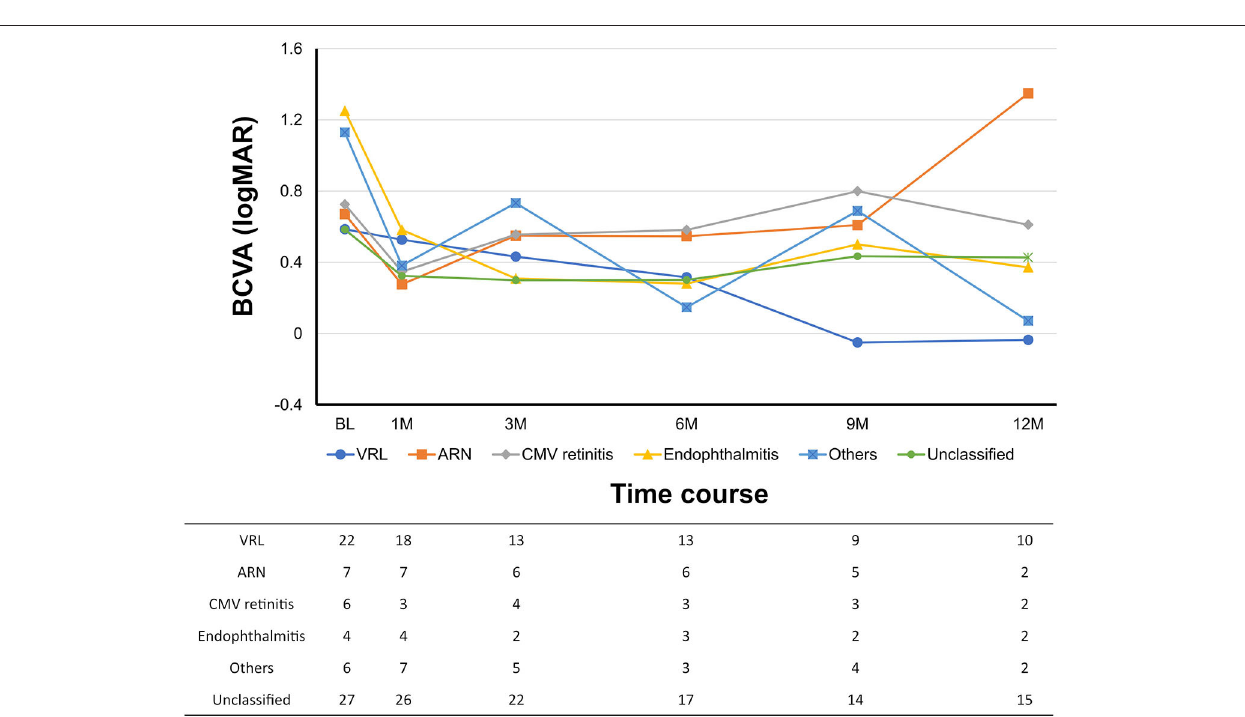
FIGURE 2 | Post-operative changes in best-corrected visual acuity (BCVA) over time according to diagnosis. Number of eyes (N) is provided at each time point. VRL, vitreoretinal lymphoma; ARN, acute retinal necrosis; CMV, cytomegalovirus.